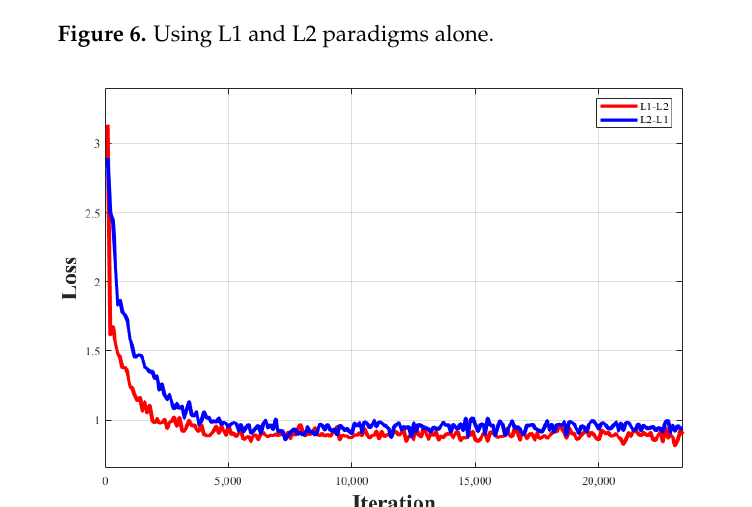
Figure 7. Using the L1 and L2 paradigms in